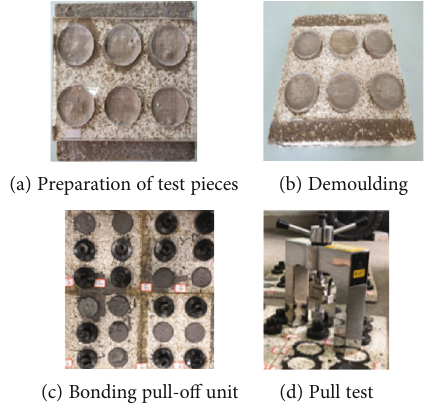
Figure 3: Drawing experiment steps.